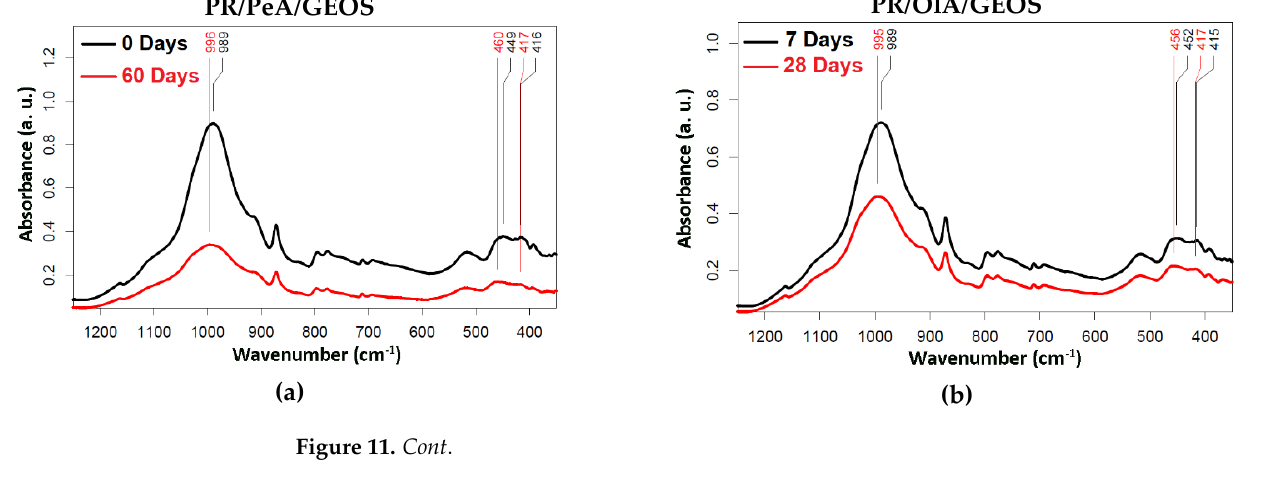
(c) Figure 11 Details of the FT-IR spectra of PR/PeA/GEOS ( a ), PR/OlA/GEOS ( b ), and PR/GrA/GEOS ( c ) samples in the 370 – 1250 cm −1 spectral range. Lines show the positions of Si-O-T banding and stretching vibrational mode bands. After 60 days of treatment for PR/PeA/GEOS and after 28 days for PR/OlA/GEOS and PR/GrA/GEOS, a shift in the Si-O-T bands to higher wavenumbers (cm −1 ) was seen. In each graph, absorbance is reported in arbitrary units (a.u.). 3. Discussion A comparison of the results of the different analyses performed on PR/ash mixtures allowed the following conclusions to be made: • The initial reduction in compressibility observed in all samples after 1 day of curing was likely due to a mere mechanical effect. In fact, it is known that pozzolanic reac- tions involving biomass ashes in the systems do not develop products in the early stage of curing [32]. In PR/PeA/GEOS, worse compressibility characteristics were observed at intermediate curing times (7 and 14 days). This could be because at this stage of the system evolution, pozzolanic reactions have already determined a con- sumption of the added ash but the newly formed compounds are still not able to give beneficial effects compensating for the gradual loss of mere mechanical benefits due to the addition of unreacted PeA. After 28 days of curing, the binding effects are stronger and they compensate for the loss of initial mechanical benefits. The com- pression curves after 1 and 28 days of curing were in fact superimposed on each other. On the contrary, the results obtained for PR/OlA/GEOS seem to indicate that pozzolanic reactions induce the formation of new compounds, the presence of which determines, at any time up to 28 days, beneficial effects compensating for the gradual loss of mechanical benefits observed in the short term (1 day) and due to the addition of unreacted OlA. Finally, the behavior of PR/GrA/GEOS suggested that af- ter 7 days of curing, new compounds had developed with improved mechanical ef-